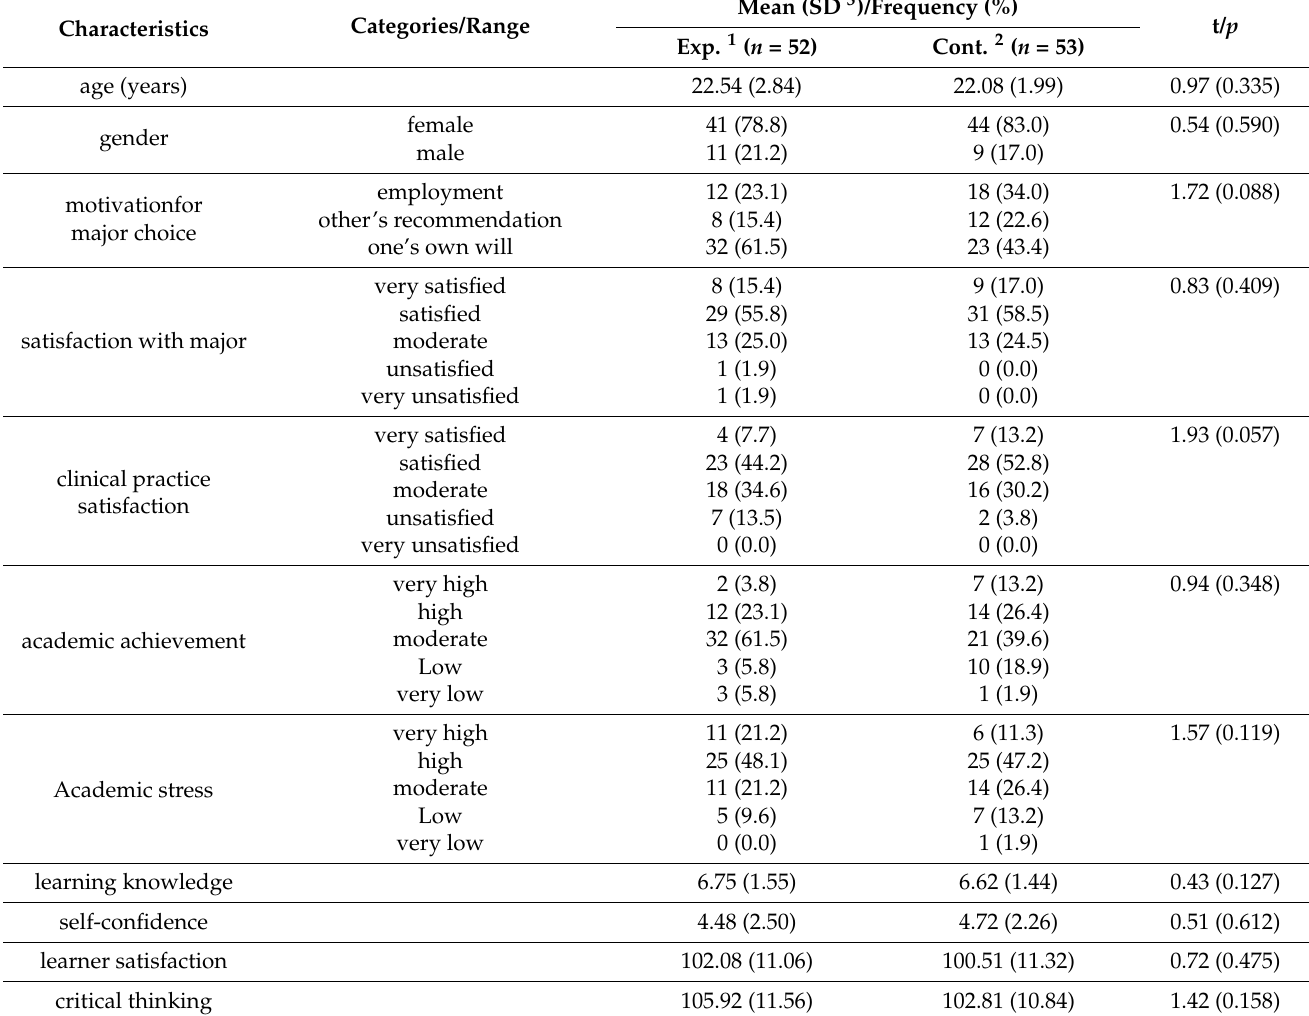
Table 2. Homogeneity test for participants’ general characteristics and